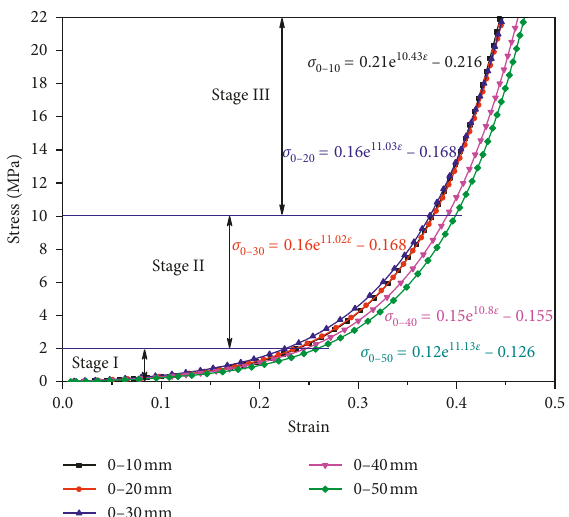
Figure 4: Stress-strain curves for gangue samples of different particle